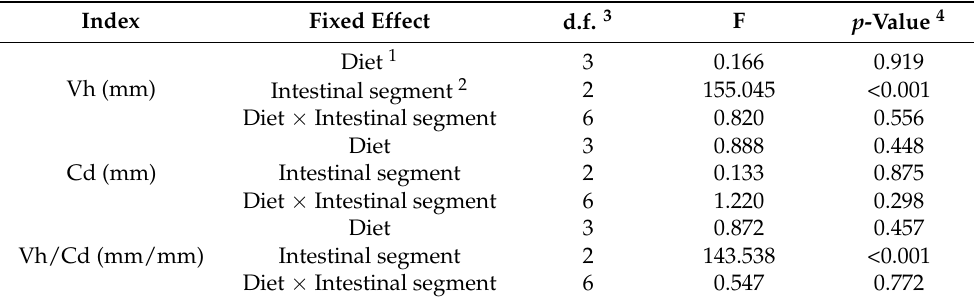
Table 7. Effects of diet, intestinal segment, and interaction between diet and intestinal segment on the intestinal morphometric indices of the broiler chickens (n = 15/treatment).